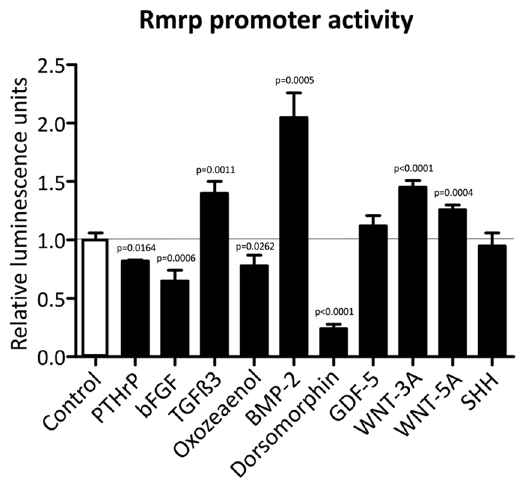
Figure 5. Rmrp promoter activity is altered by chondrogenic morphogens. Rmrp promoter responsiveness to different chondrogenic morphogens and pathways was determined by transfection of the pGluc-Rmrp-prom reporter plasmid, comprising the 1500 nucleotide sequence upstream of the mouse Rmrp RNA transcription start site. ATDC5 cells were transiently co-transfected with this reporter and pGL4.20[luc2/Puro]-CMV to normalize for transfection efficiency. Transfected cells were exposed for 24 hours to either 100 nM PTHrP, 15 ng/ml bFGF, 10 ng/ml TGF β 3, 0.5 μ M (5 Z )-7-Oxozeaenol, 30 ng/ml BMP-2, 10 μ M dorsomorphin, 100 ng/ ml GDF-5, 15 ng/ml WNT-3A, 15 ng/ml WNT-5A or 150 ng/ml SHH. These concentrations were chosen based on their use as described in literature. Promoter activity is depicted as fold induction relative to control. Data was normalized to pGL4.20[luc2/Puro]-CMV and represents the average value of 4 biological replicates plus standard deviation. For statistical evaluation an independent samples t-test was performed relative to control using GraphPad Prism 5. p-values are indicated. Presented graphs are representative examples of three independent